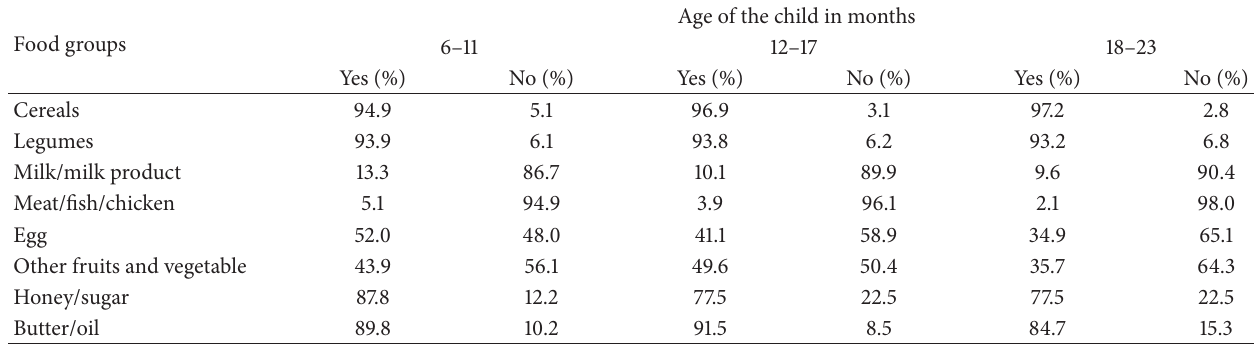
Table 2: Types of food given to children aged 6–23 months in the past 24 hours by age groups ( 𝑛 = 476 ) Lasta Woreda, Amhara, Northeast Ethiopia, April 2015 to October 2015.